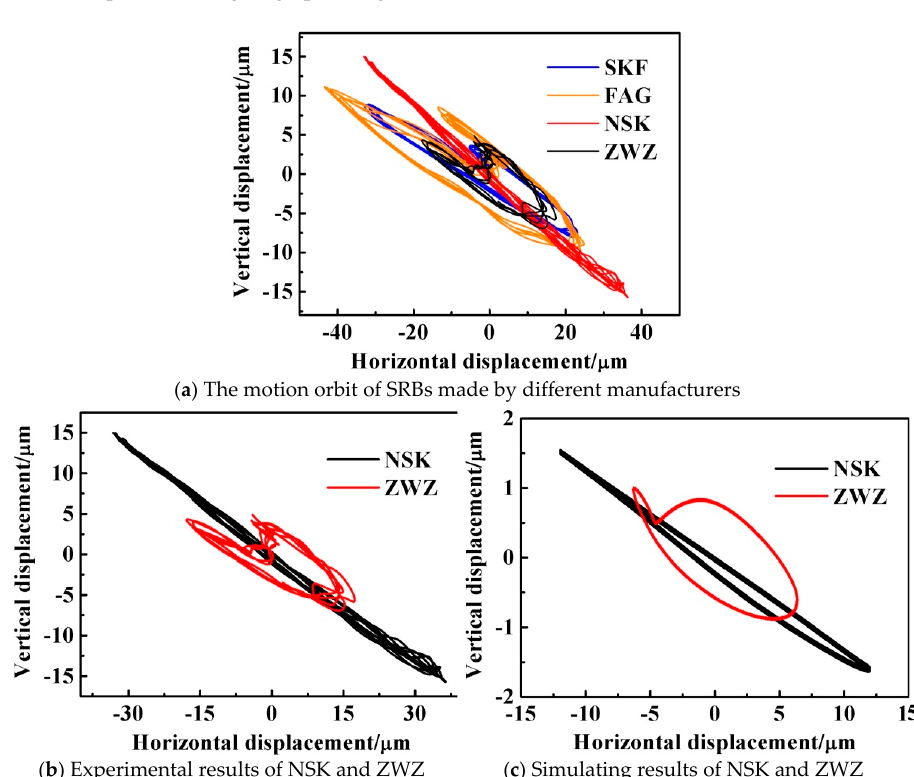
Figure 23. The motion orbit of SRBs with type 22215 under the limiting self ‐ aligning operating conditions.